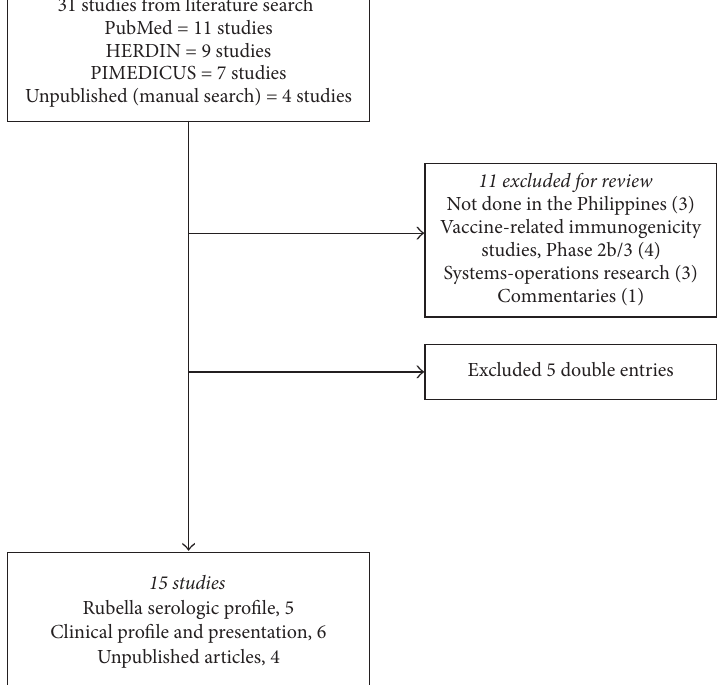
Figure 1: Flow of articles